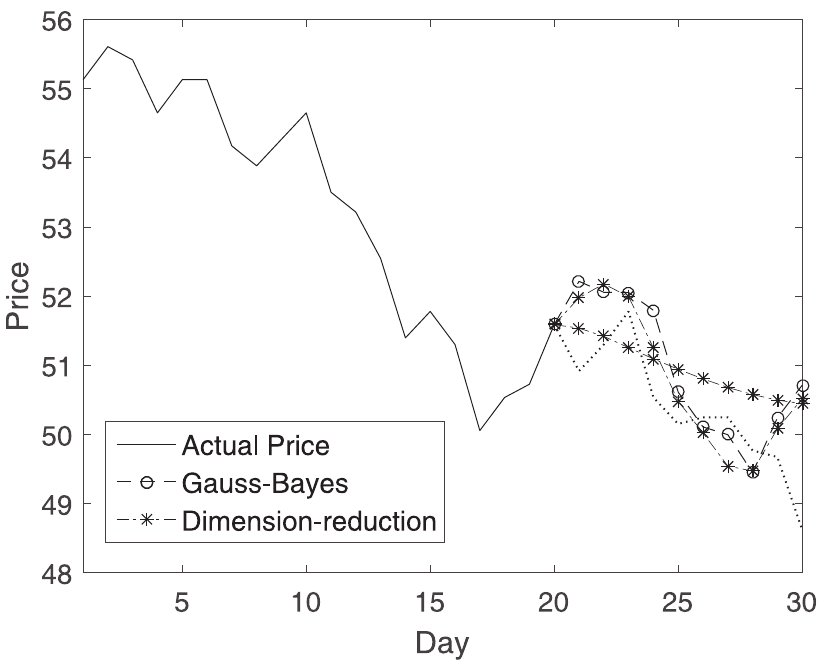
Fig 1. Predicting price for M + 1 to N days, actual price: Solid line, GB: − o − , RD: − � − (two lines, one for a small value of L, and one for a relatively large number).